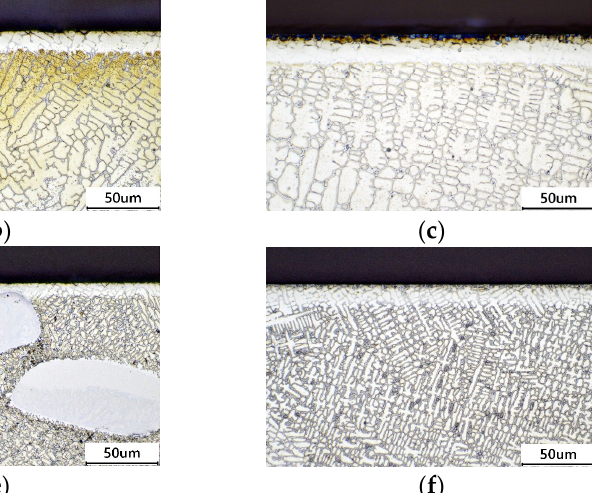
Figure 3. Cross-sectional micrographs of the AISI 316 L steel-based WC composite layers with various WC compositions and nitriding temperatures: ( a ) WC 20 wt.% at 400 °C, ( b ) WC 20 wt.% at 425 °C, ( c ) WC 20 wt.% at 450 °C, ( d ) WC 40 wt.% at 400 °C, ( e ) WC 40 wt.% at 425 °C, and ( f ) WC 40 wt.% at 450 °C.